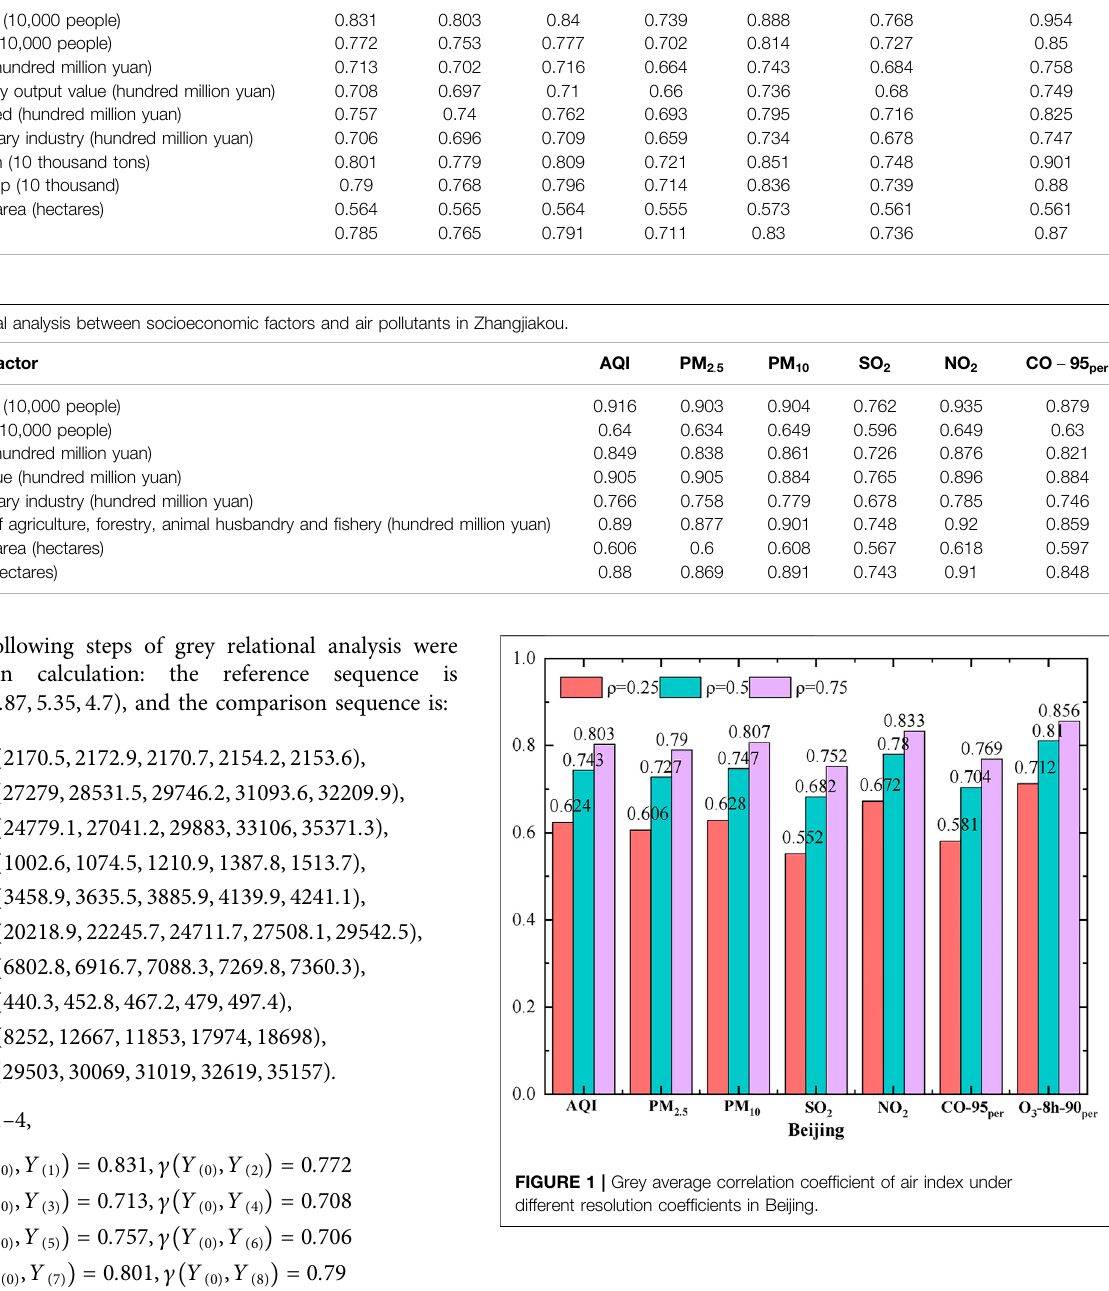
TABLE 5 | Relational analysis between socio – economic factors and air pollutants in Beijing. Socio-economic factor Resident population (10,000 people)